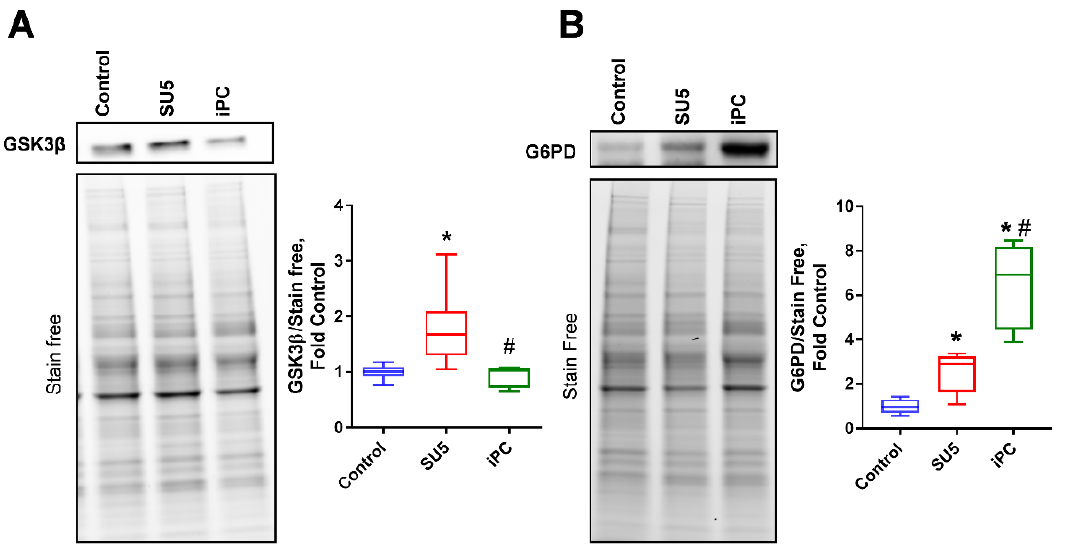
Figure 4. PC inhibitor balanced glycolysis by regulating Glucose 6-phosphate dehydrogenase (G6PD), and glycogen synthase kinase 3 beta (GSK3 β ). ( A ) GSK3 β , an inhibitor of glycogen synthase, increased